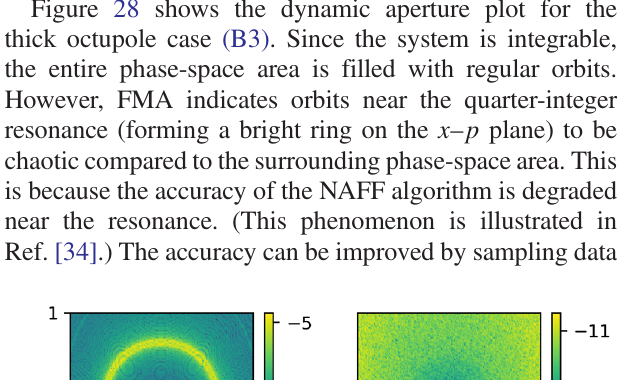
T ¼ 512 . In the case of E ¼ 1 = 9 , chaotic bands appear on the dynamic aperture plot. In this case also, FMA tends to largely overestimate the chaotic region at T ¼ 512 while REM tends to slightly underestimate the chaotic region at T ¼ 512 . Note that some chaotic resonant islands reported by FMA for E ¼ 1 = 9 and T ¼ 512 are vanishing for T ¼ 2048 . In both energies, both indicators converged and agreed with each other as T becomes long. However, the convergence looks relatively faster for REM.